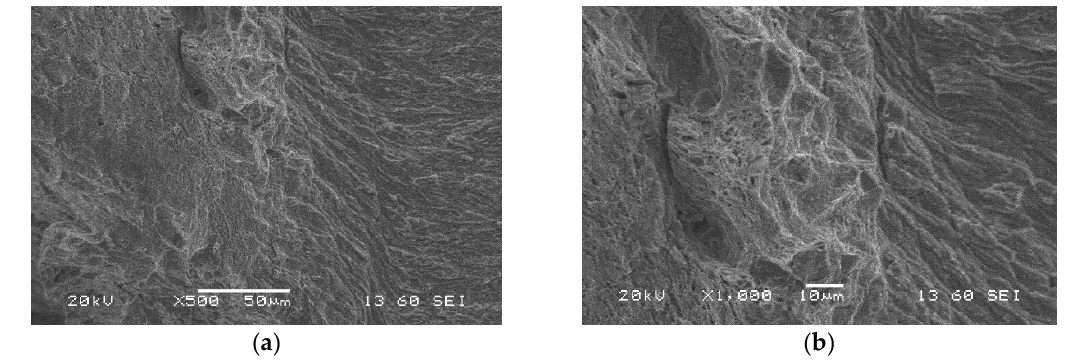
Figure 16. Microstructures of the transient region (fatigue pre-crack and crack propagation) of the S700MC (specimen No. 7) captured after CTOD test using SEM; magnifications: ( a ) ×500; ( b ) ×1000.